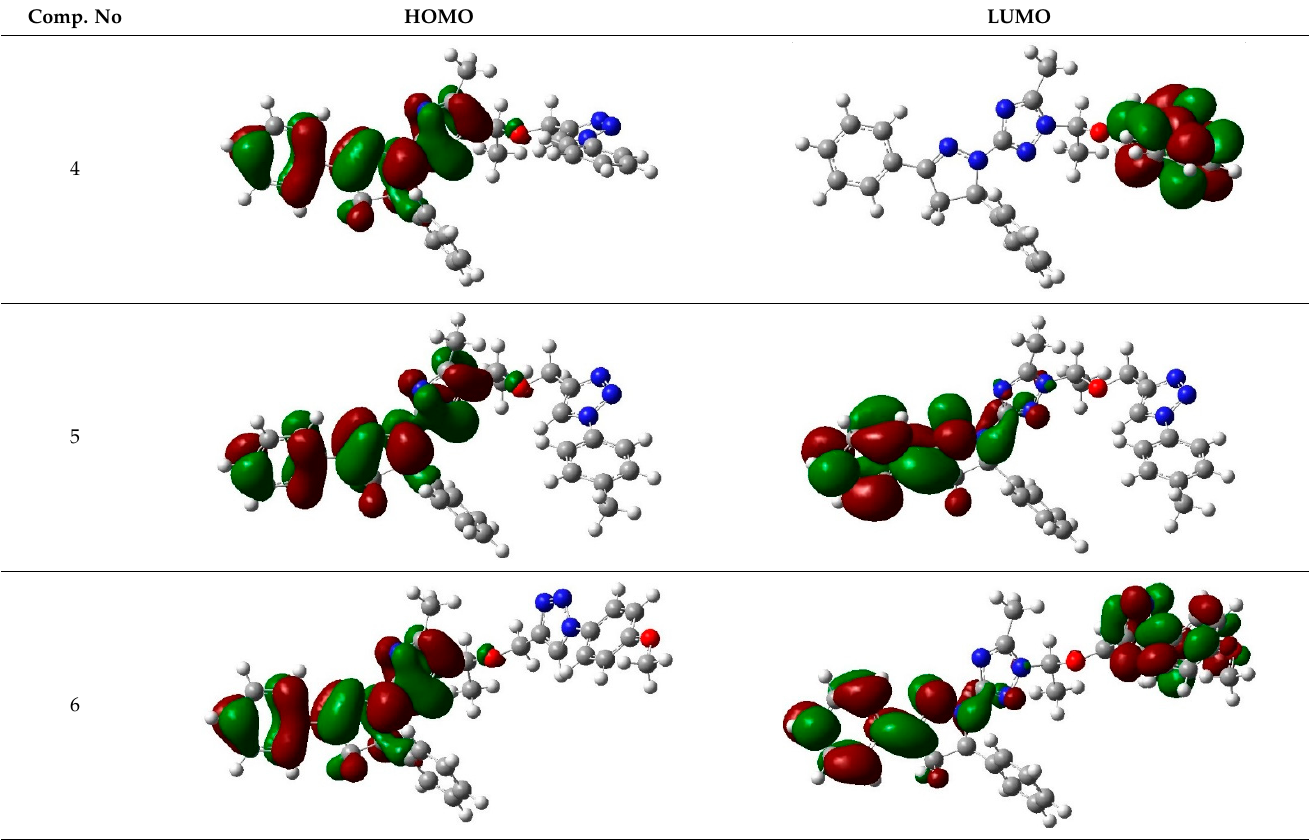
Table 1. Calculated HOMO and LUMO orbitals for compounds 4 – 9 by (B3LYP/6-311++G(d,p)) level of theory in the gas phase. Comp. No